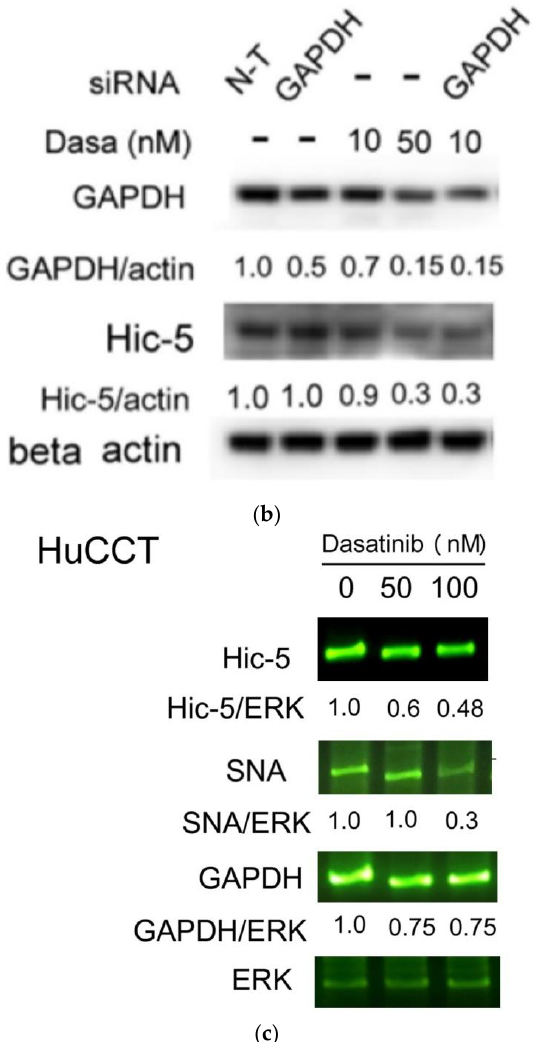
Figure 5. GAPDH mRNA and protein are downregulated by dasatinib and required for HuCCT1 migration. HuCCT1 cells were transfected with GAPDH siRNA and/or treated with the Src inhibitor dasatinib (Dasa) at indicated concentrations ( a , b ) or treated with dasatinib at indicated concentrations ( c ) for 48 h. Transwell migration assay ( a ), Western blot ( b ) and RT-PCR ( c ) were performed using β actin ( b ) and ERK ( c ) as internal controls. In ( a ), the images are the crystal-violet-stained, migrated cells pictured under a 40× magnification. The resultant quantitative data obtained using ImageJ software are shown in lower right panel. Relative motility was calculated taking the data of the nontargeting (N-T) group as 100%. (**) represents the statistical significance ( p < 0.05, N = 3) of the difference between the indicated samples and the nontargeting (N-T) group. In ( b , c ), the numbers below each of the bands indicate the relative band intensities, taking the data of β actin ( b ) and ERK ( c ) as 1.0. The data shown are the average of two reproducible results, with a coefficient of variation (C.V.) of 9%.